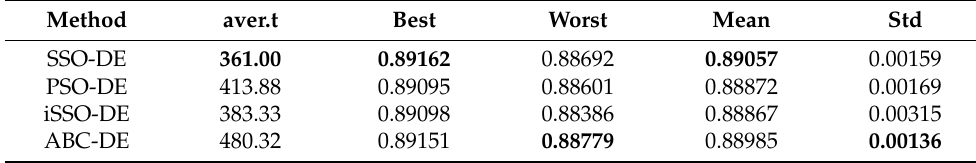
Table 21. Experiment results for spring (autumn).